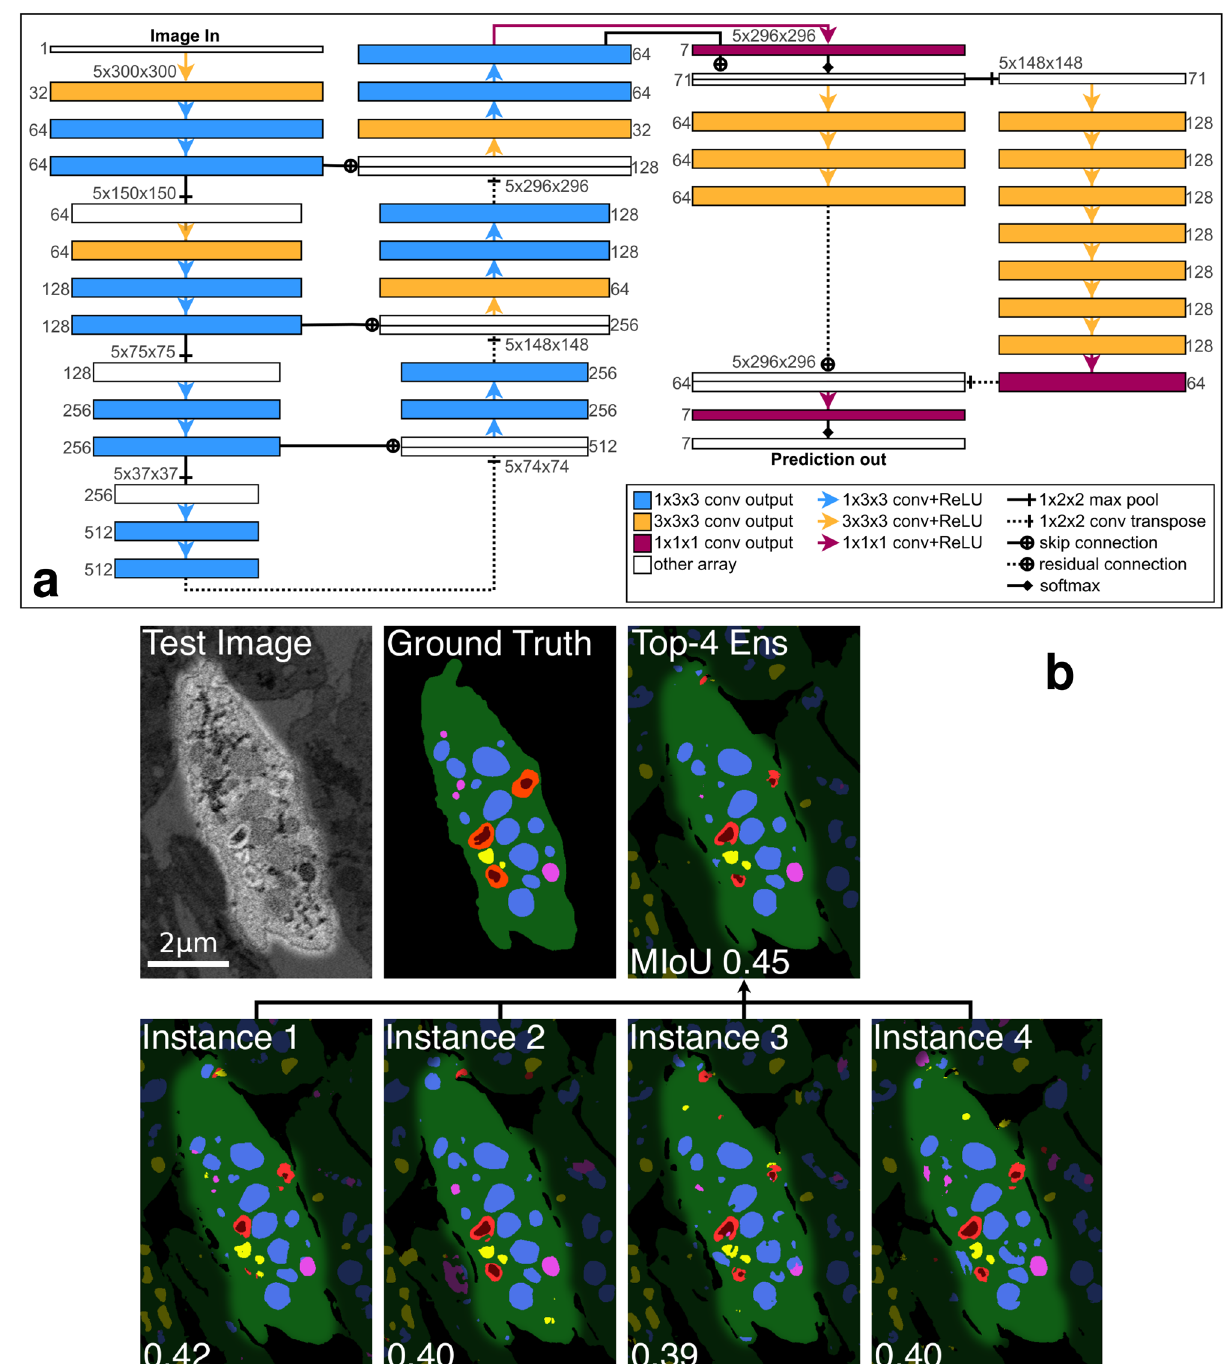
Figure 2. Methods. ( a ) Diagram of the 2D–3D + 3 × 3 × 3 network architecture, the best design tested in this paper. A 1-channel 3D image is passed through the network to produce a 7-channel output prediction of per- voxel probability distributions over the 7 label classes. Boxes represent multidimensional arrays, and arrows represent operations between them. Number triplets along box tops are array spatial axis sizes in ( z , y , x ) order. Numbers along box sides are array channel axis sizes. ( b ) Illustration of initialization-dependent performance of trained segmentation networks, and exploiting it for ensembling. An image of the test cell and ground truth labels are compared with segmentations of the best 4 trained 2D–3D + 3 × 3 × 3 network instances and an ensemble formed from them. The ensemble improves MIoU ( org ) by 7.1% over the best single